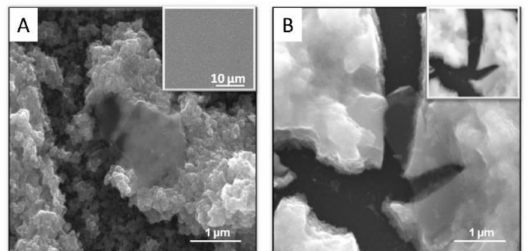
Figure 5. ( A – D ) SEM images for IrO x -GO hybrid at various scales showing typical cracks and the millfeuille nanostructure [28]. Yellow big square shows a magnified vision of the zone at small square. With permission from Elsevier.